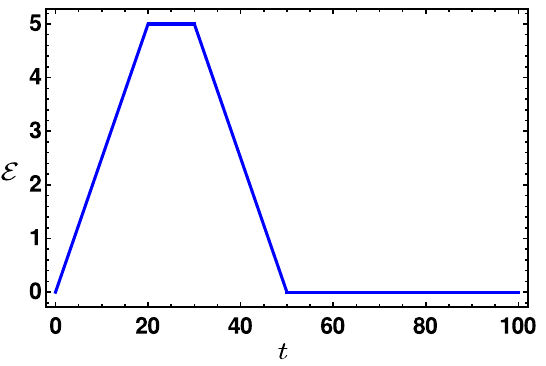
Figure 10 . Holographic entanglement negativity E vs time t is plotted for two adjacent intervals of lengths ℓ 1 = 50, ℓ 2 =